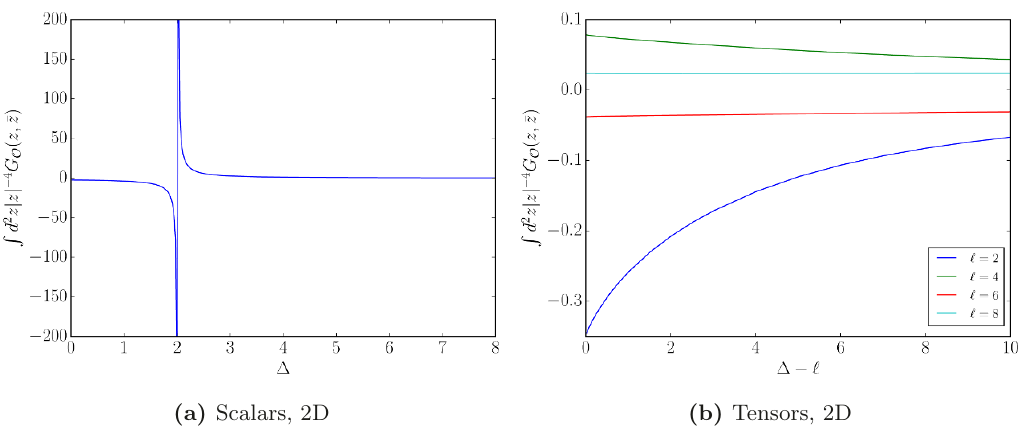
ˆ contributes to the beta function. These O × O